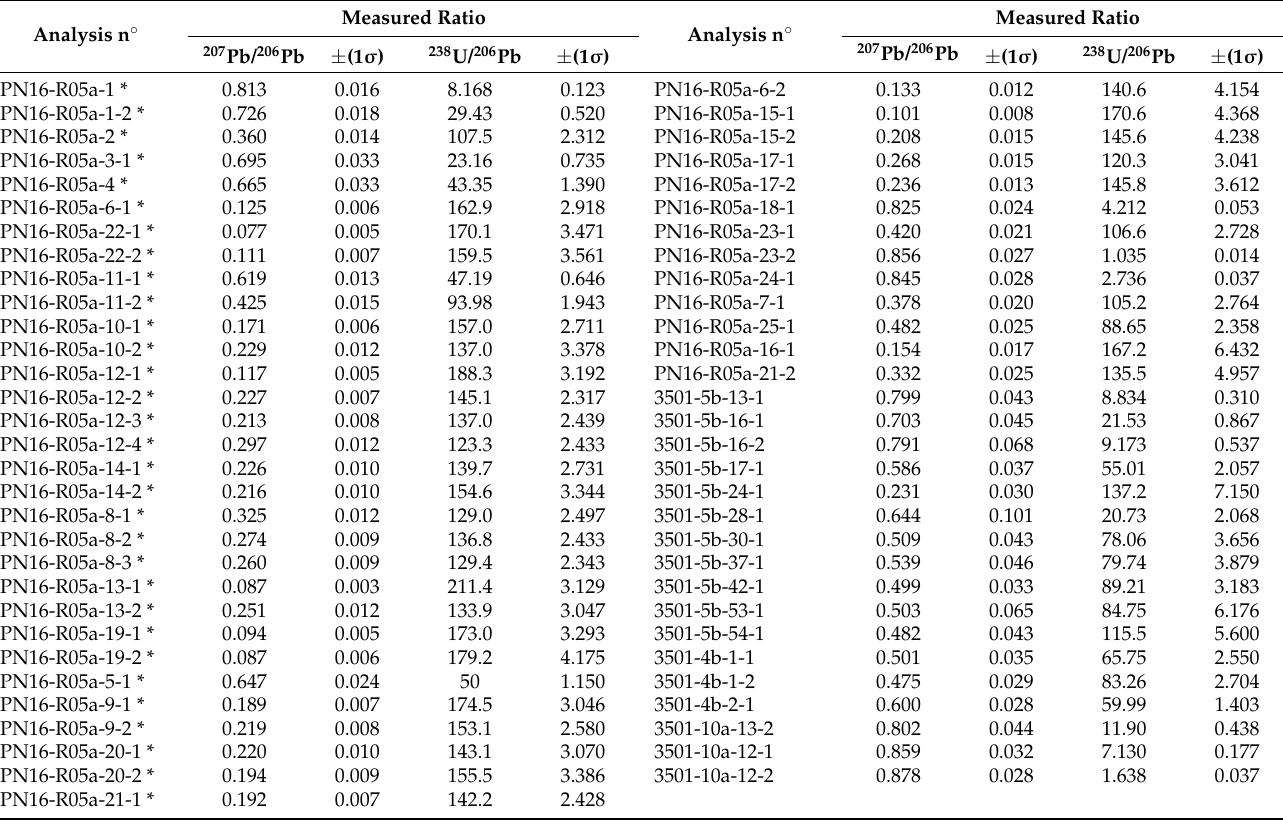
Table 3. Summary of the LA-ICP-MS raw data for Peisey-Nancroix (PN16-R05a) and Mac ô t-la Plagne monazite (3501-4b, 3501-5b, and 3501-10a). Note that monazite grains are referenced by the first